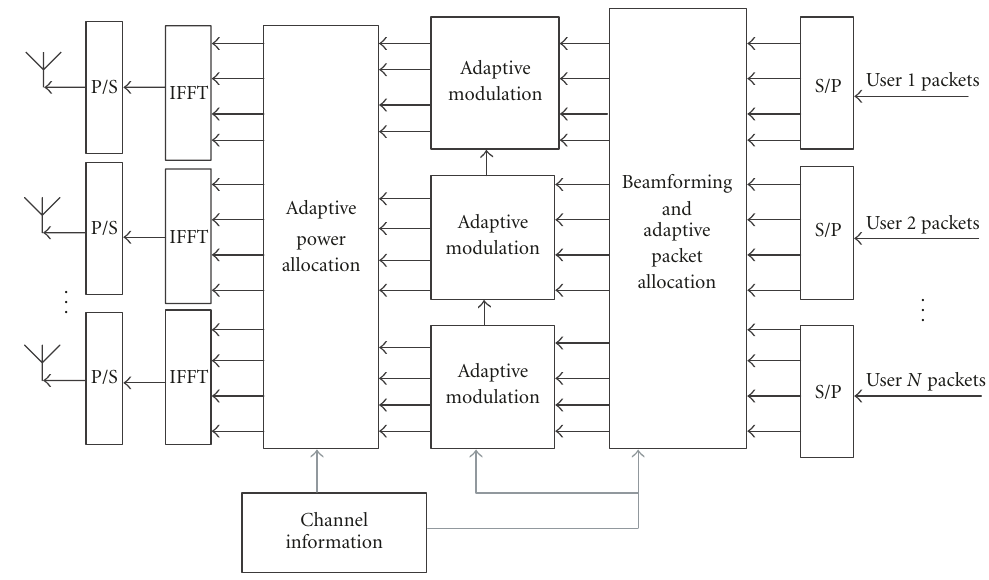
Figure 2: Base station downlink